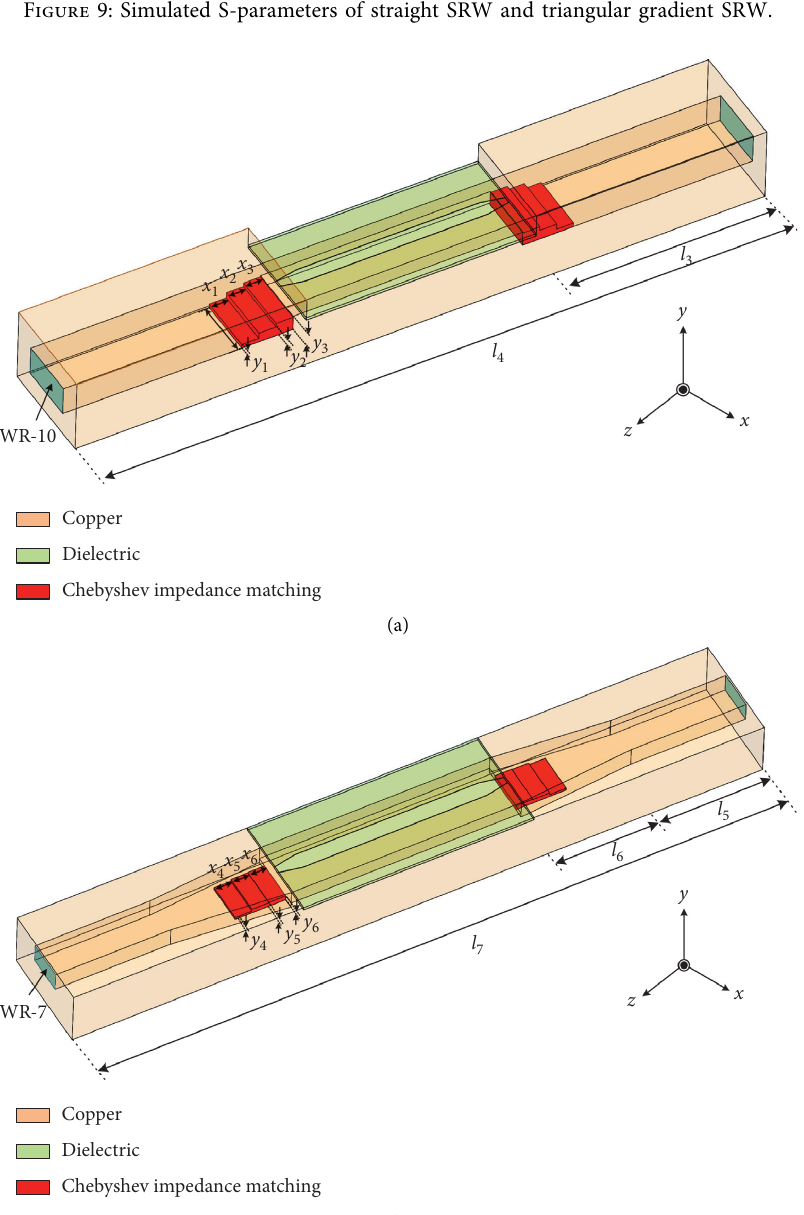
Figure 10: Two transitions from the SRW in Figure 2 to standard waveguides WR-10 and WR-7: (a) W band transition and (b) D band transition.